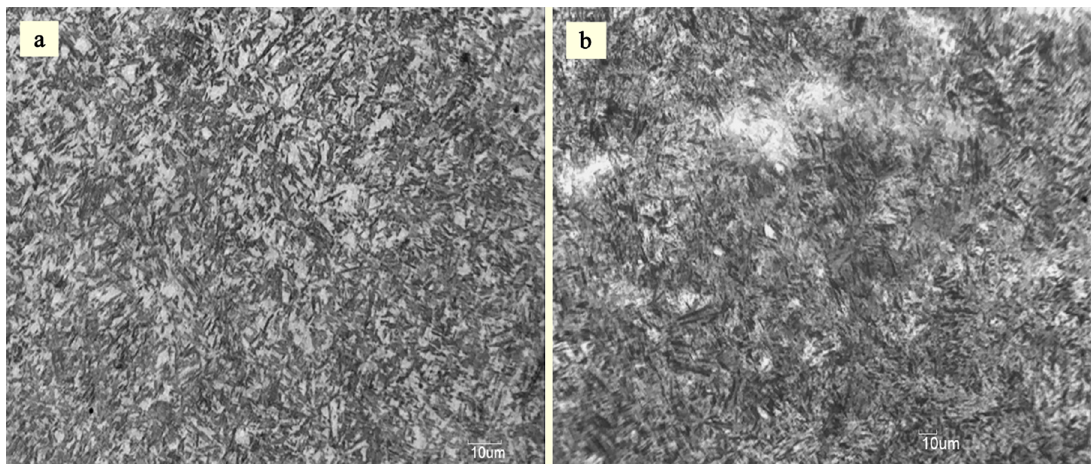
Figure 7. Optical micrographs of AISI 4340 steel austenitized at 800 °C for 30 minutes cooled in: (a) water and (b) oil (magnification